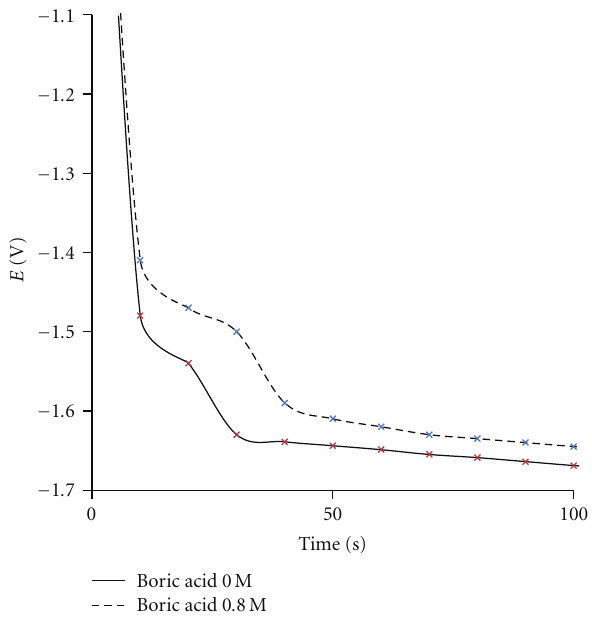
Figure 2: Chronopotentiometric curves at 5mA/cm 2 on steel elec- trode.